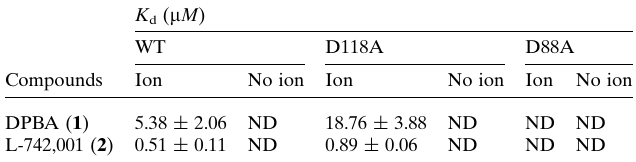
Table 2 Determination of the dissociation constants of ENDO proteins (WT and D118A and D88A mutants) with DPBA ( 1 ) and L-742,001 ( 2 ) in the presence or absence of ions by microscale thermophoresis (MST). The concentration of labelled protein was kept constant at 100 n M , while the concentration of the compound was varied from 500 m M to 15 n M to yield 16 serial concentrations. ND, not